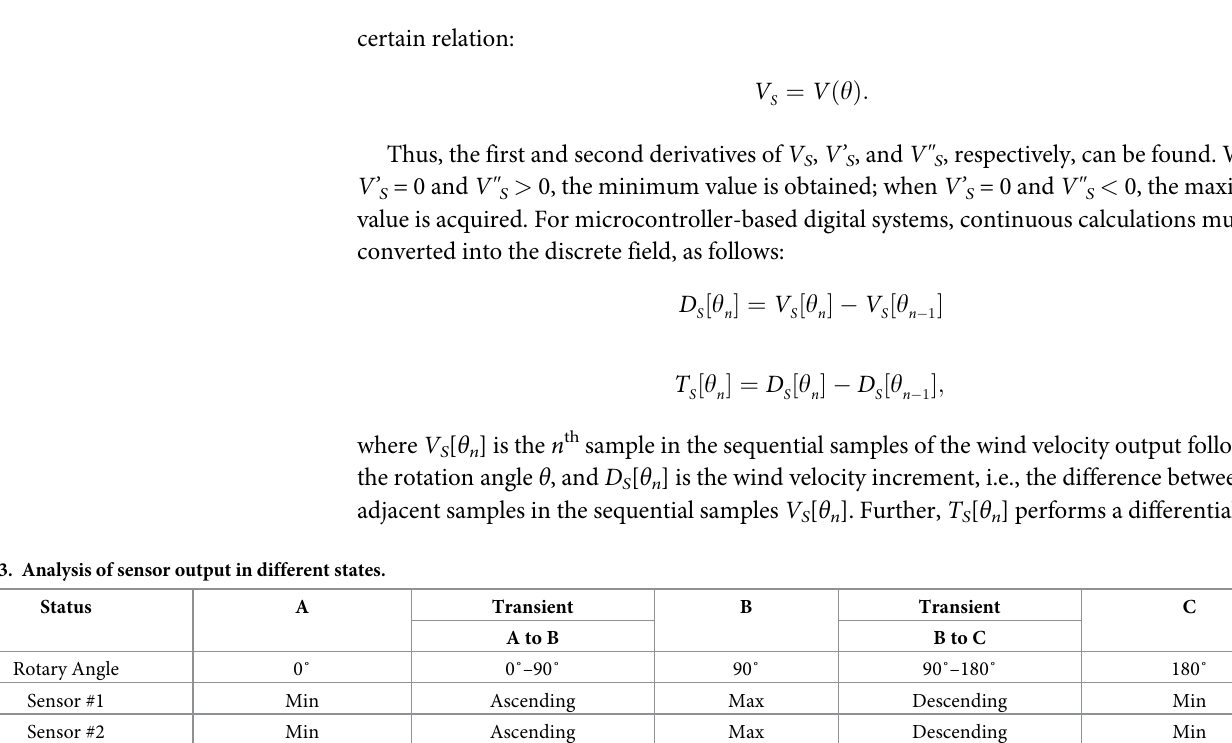
, V’ , and V" , respectively, can be found. When S S S = 0 and V" < 0, the maximum S S